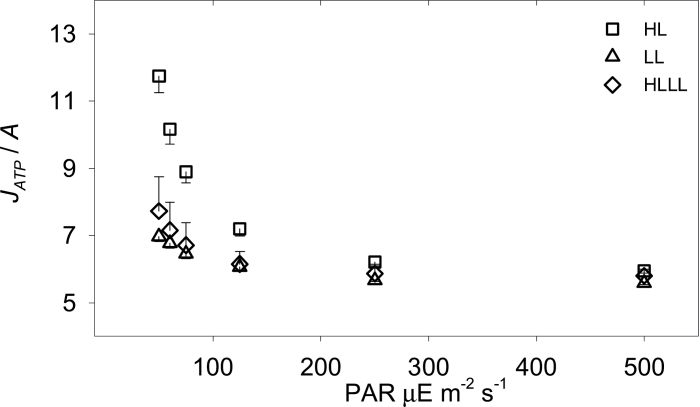
Measured ATP cost of net assimilation (J
ATP/A) for HL plants (squares), LL plants (triangles), and HLLL plants (diamonds). Error bars represent one SE (n = 6).